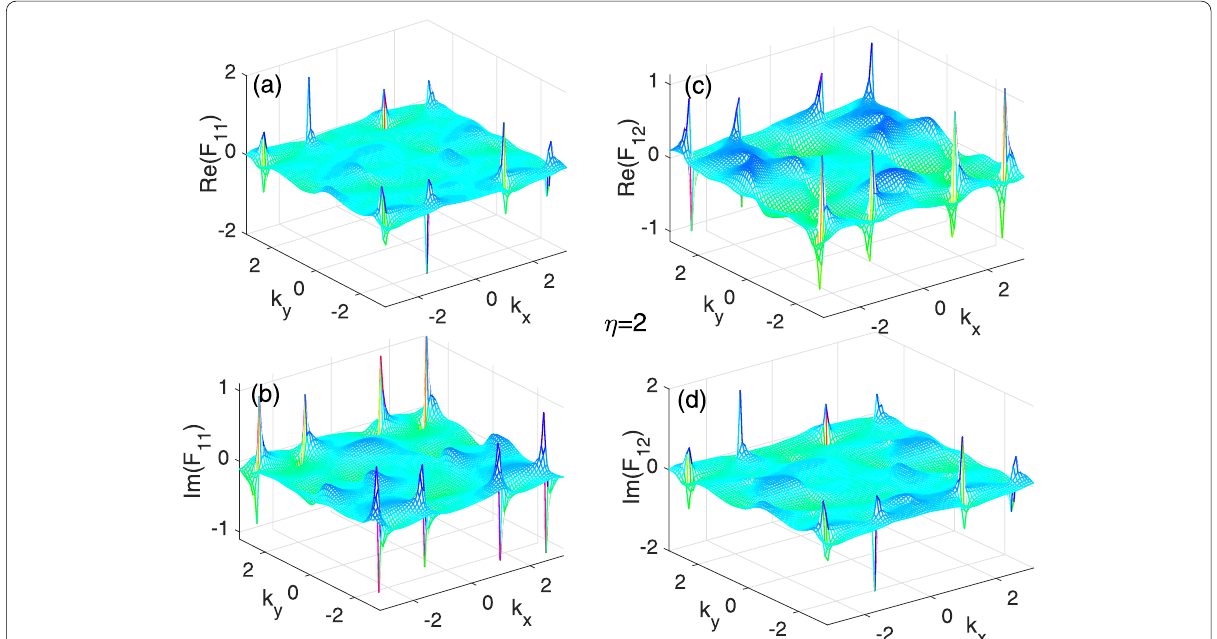
Fig. 4 (Color online): The complex Berry curvatures in the Brillouin zone for the parameter parameters η = 2 . a and b are the real and imaginary parts of the diagonal component of the complex Berry curvature F 11 , respectively. c and d are the real and imaginary parts of the off‑diagonal complex Berry curvature F 12 , respectively